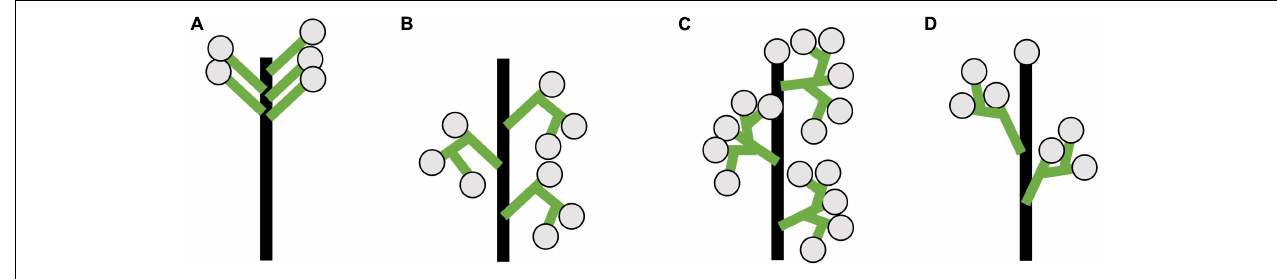
FIGURE 2 | Diagrams of inflorescence architecture observed for umbellate inflorescences in this study. (A) Sciadium, a type of true umbel. (B) Thyrse with monochasial bostryces. (C) Thyrsoid with dichasia. Represents an early developmental stage Butomus umbellatus as in later stages cymes become monochasial. (D) Thyrsoid with monochasial cincinni. (B–D) Depicted without differential internode lengths would be observed in umbellate taxa. Floral subtending bracts (aka pherophylls) and floral bracts (aka prophylls) are not included these depiction (see Prenner et al., 2009: Box